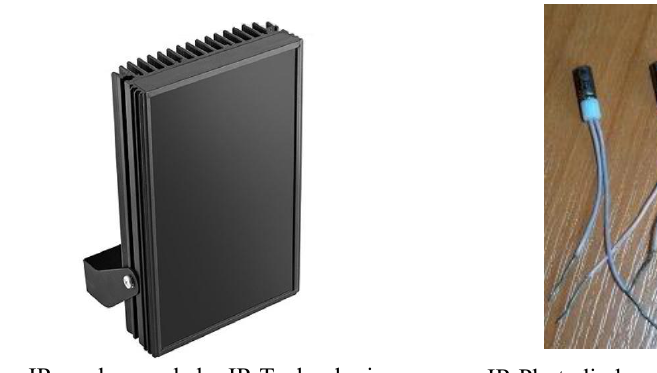
Fig. 5. Some optical components produced in Russia and used in the